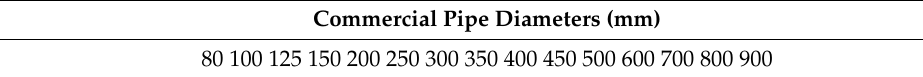
Table 5. Set of commercial diameters for ductile iron